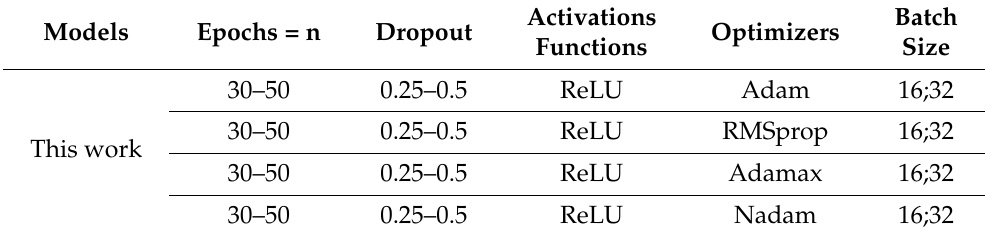
Figure 7. Five-fold cross-validation scheme. Table 2. Hyperparameters and training settings for the suggested